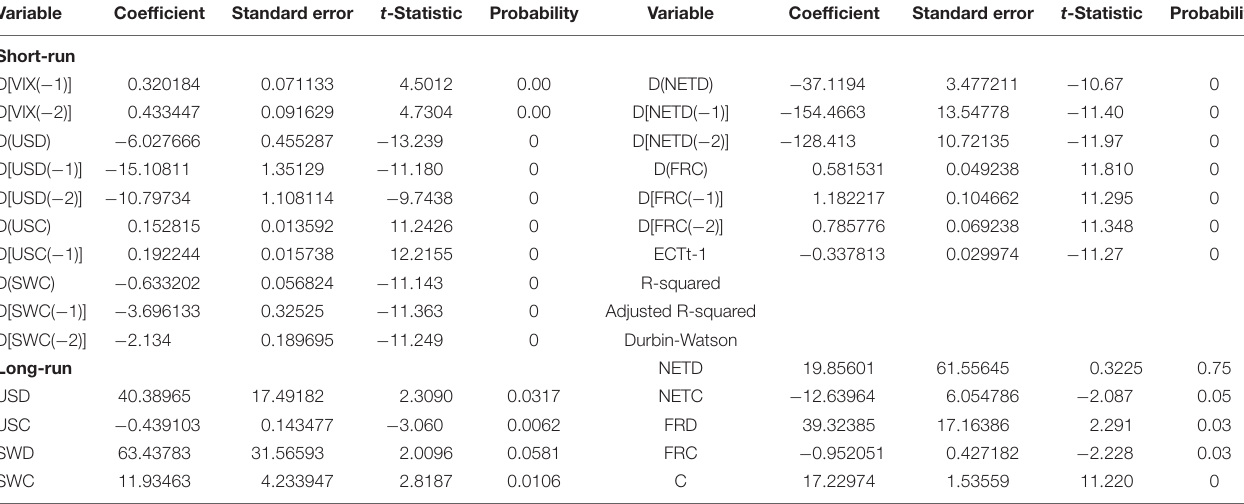
TABLE 5 | Long-run and short-run parameters of model B.